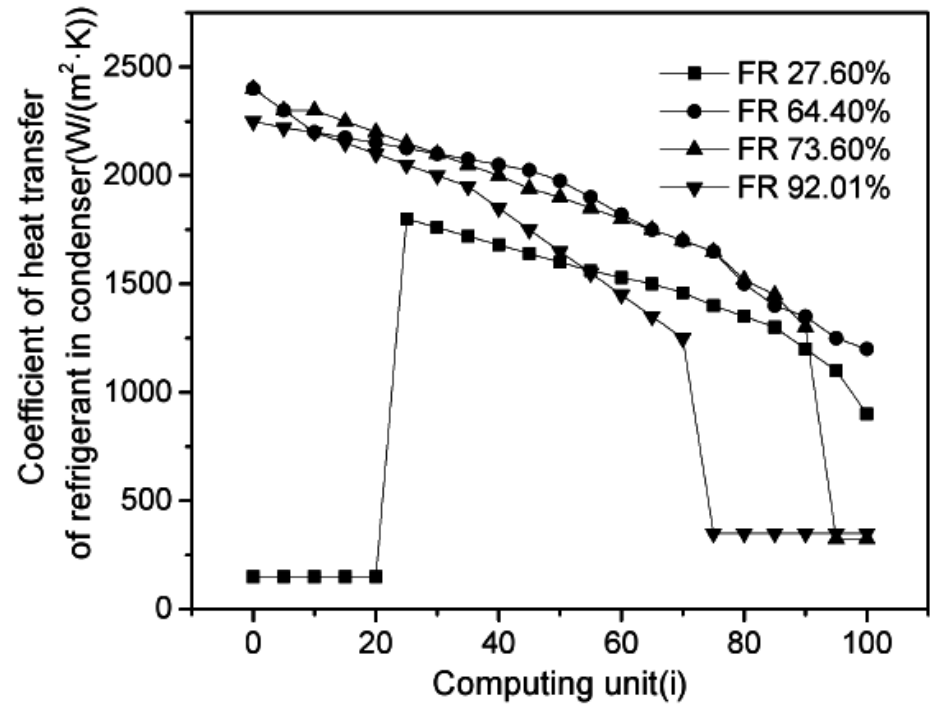
Figure 12. Schematic diagram of refrigerant heat transfer coefficient distribution along the calculation unit in the condenser.